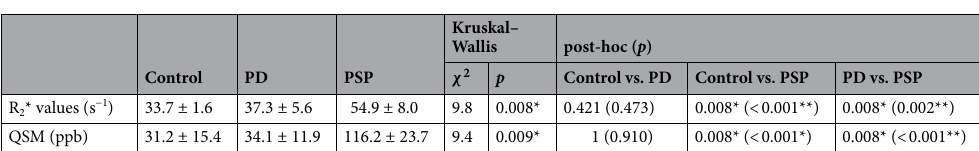
Table 1. Comparison of R 2 * and QSM in the region between SN and RN among PD, PSP and healthy control groups. Data are shown as mean ± standard deviation. Post-hoc ( p ) = p -values from post-hoc analysis of Mann–Whitney U test. Control = healthy control; PD = Parkinson’s disease; PSP = progressive supranuclear palsy; SN = substantia nigra; RN = red nucleus. * p < 0.05 (For post-hoc analysis, * p < 0.05/3 and ** p < 0.005/3 after Bonferroni